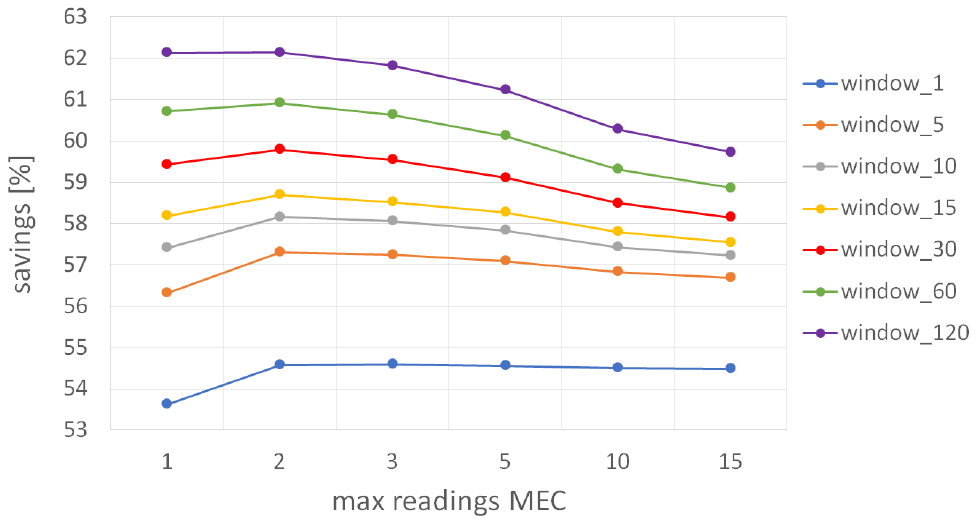
Figure 9. Energy savings when m worker =